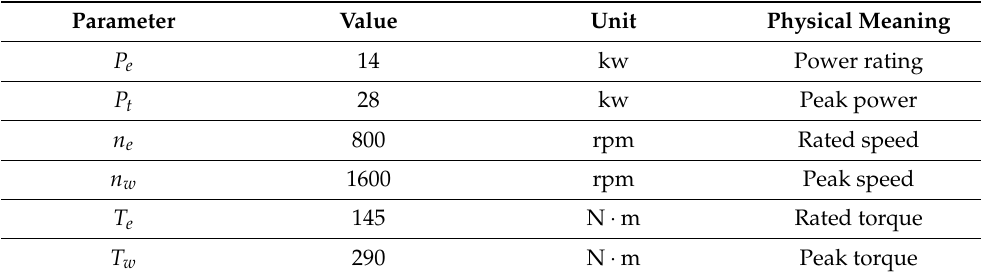
Table 3. Wheel motor parameters.